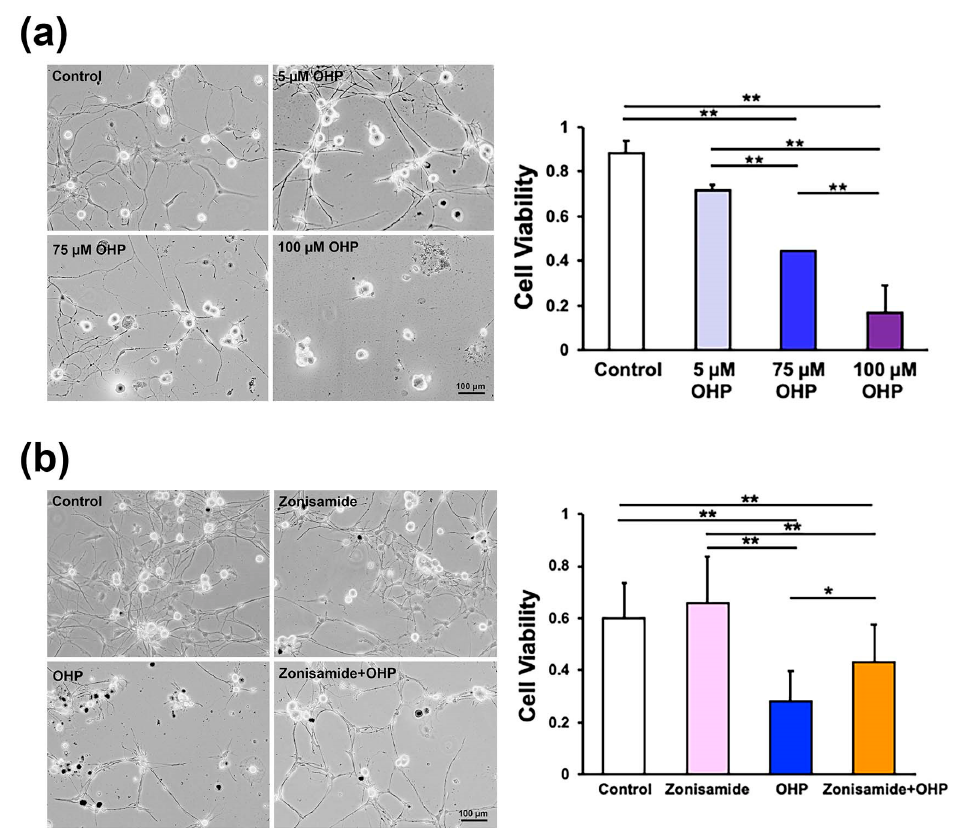
Figure 1. Pretreatment with zonisamide alleviates OHP-induced toxicity against primary cultured adult rat DRG neurons: ( a ) OHP induces DRG neuronal death in a dose-dependent manner; the representative phase-contrast micrographs of DRG neurons (left) and the average cell viability ratios at 24 h after the exposure to the different concentrations of OHP (right). ( b ) Preincubation of 100 μ M zonisamide (for 24 h) diminishes the cell death due to exposure to 75 μ M of OHP for 24 h; representative phase-contrast micrographs of DRG neurons (left) and the average cell viability ratios at 24 h after the exposure to the respective culture conditions (right). Data are presented as the mean ± standard deviation ( SD ) of ( a ) 6 and ( b ) 16 experiments, respectively; **: p < 0.01; *: p < 0.05 (as defined by Tukey–Kramer).